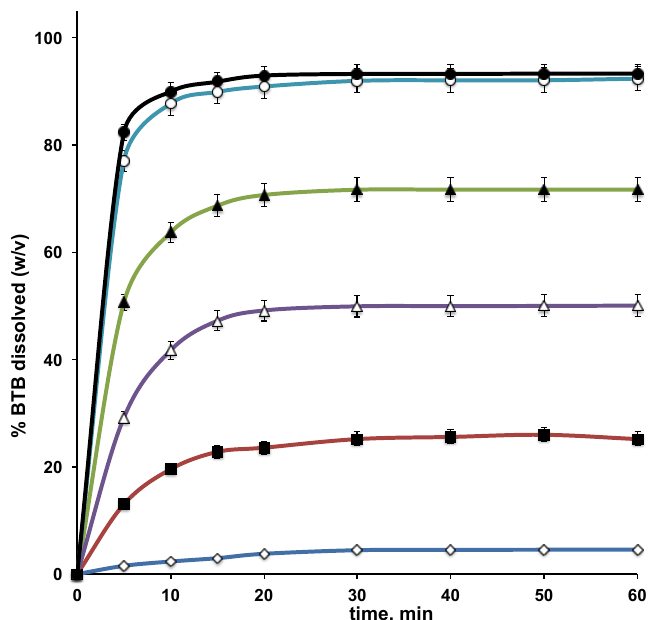
Figure 3. Dissolution curves of butamben (BTB) alone ( ♦ ), or from its equimolar physical mixture ( ∎ ), kneaded ( △ ), coevaporated ( ▲ ), coground ( ○ ), and colyophilized ( • ) products with RAMEB. Table 2. Percentage dissolved at 10 min (PD10) and dissolution efficiency at 60 min (DE60) of butamben (BTB) alone and from its equimolar physical mixture (PM), kneaded (KN), coevaporated (COE), coground (GR), and colyophilized (COL) products with RAMEB. Sample PD10